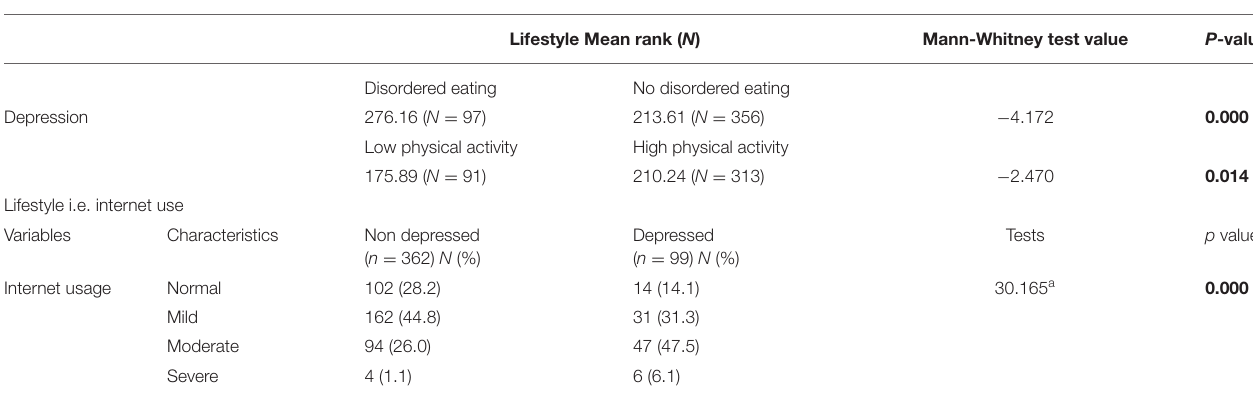
TABLE 3 | Lifestyle and adolescent depression. Lifestyles i.e. eating patterns and physical